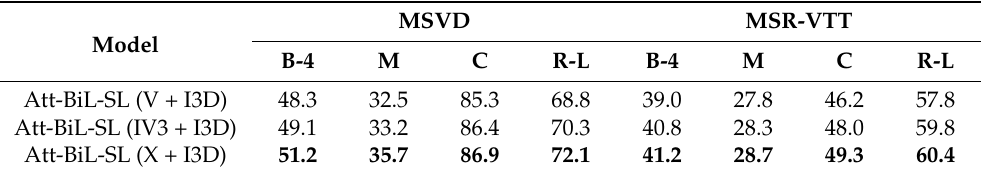
Table 1. The performance evaluation of our model in MSVD and MSR-VTT datasets. Here, the V, IV3, X, and I3D denote the VGG-16 net, InceptionV3 net, Xception net, and Inflated 3D network, respectively. Text with bold marks denote the best results in evaluation metrics (percentile